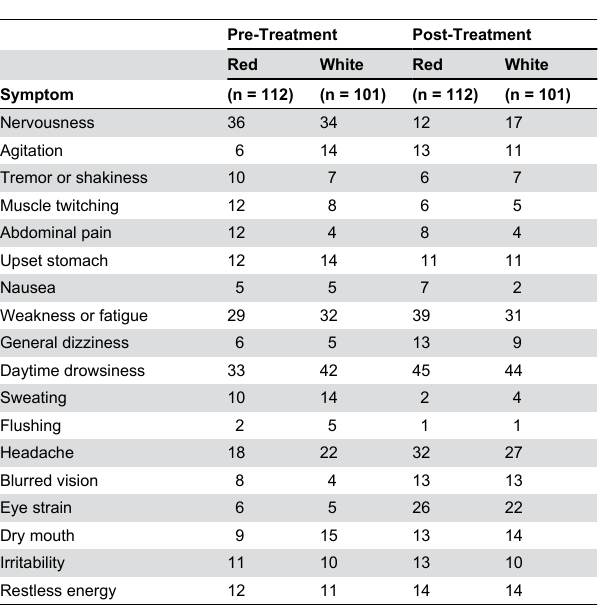
Table 2. Percentage of Side Effects Reported for Dim Red and Bright White Light at Pre-Treatment and Post-